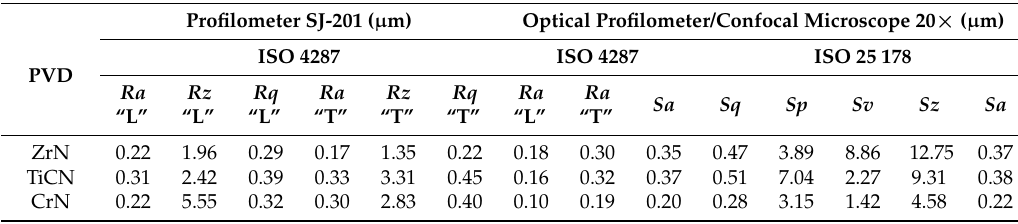
Table 4. Surface parameters of PVD coatings deposited on the material 1.3343/55–56 HRc.